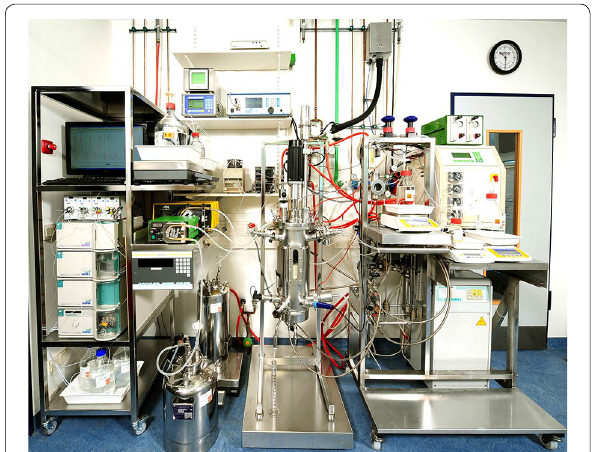
Fig. 2 Biotechnological plant for the production of antimicrobial peptides manufactured by Cornelissen. A 15-L fermenter with extended in-, on-, and at-line measurements (e.g., DO, temperature, pH, turbidity, oxygen, and carbon dioxide in off-gas, media components via HPLC, and pressure), controlled feeding and harvest for (repeated) fed batch and cyclic processing and balancing of all feeds and